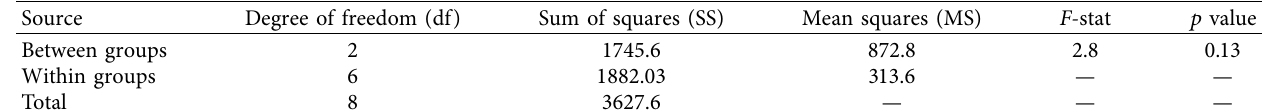
Table 10: ANOVA table of SOC stock between soil layers for oak forest.